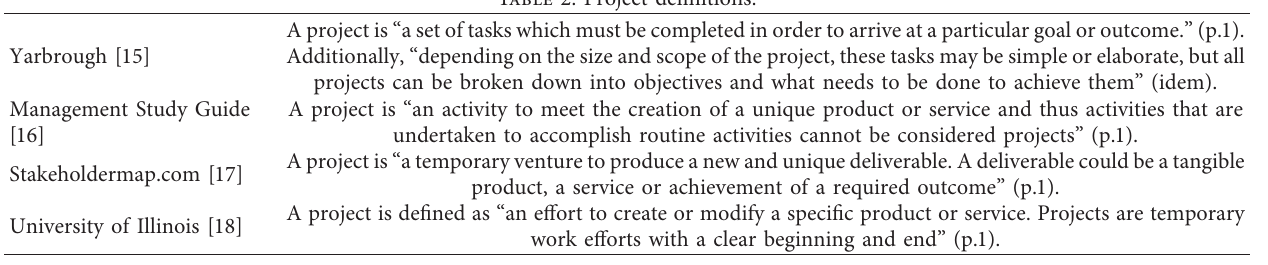
Table 2: Project definitions.